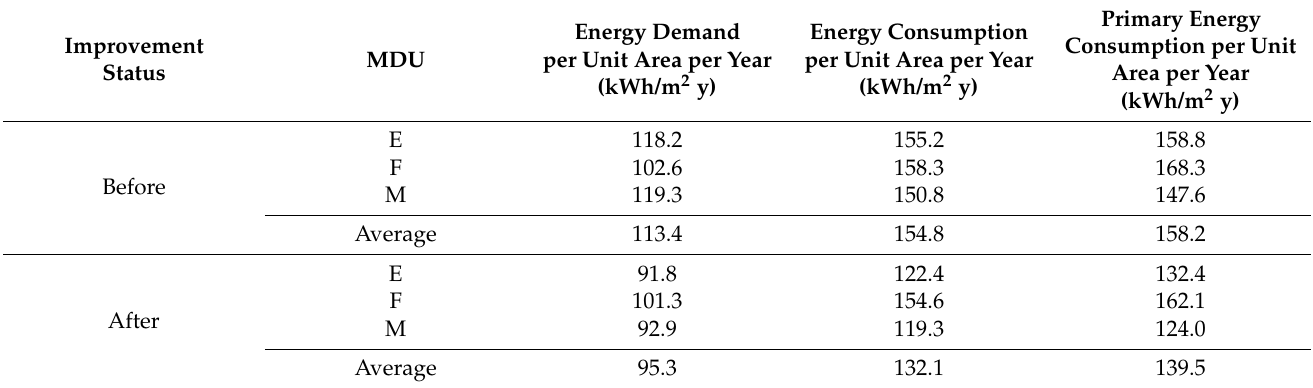
Table 6. Changes in energy demand and energy consumption of E, F, J, M, and P MDU complexes before and after ventilation system